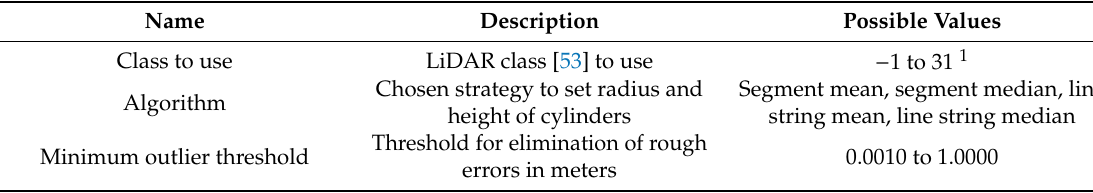
Table 7. List of the editable parameters of the VCTS